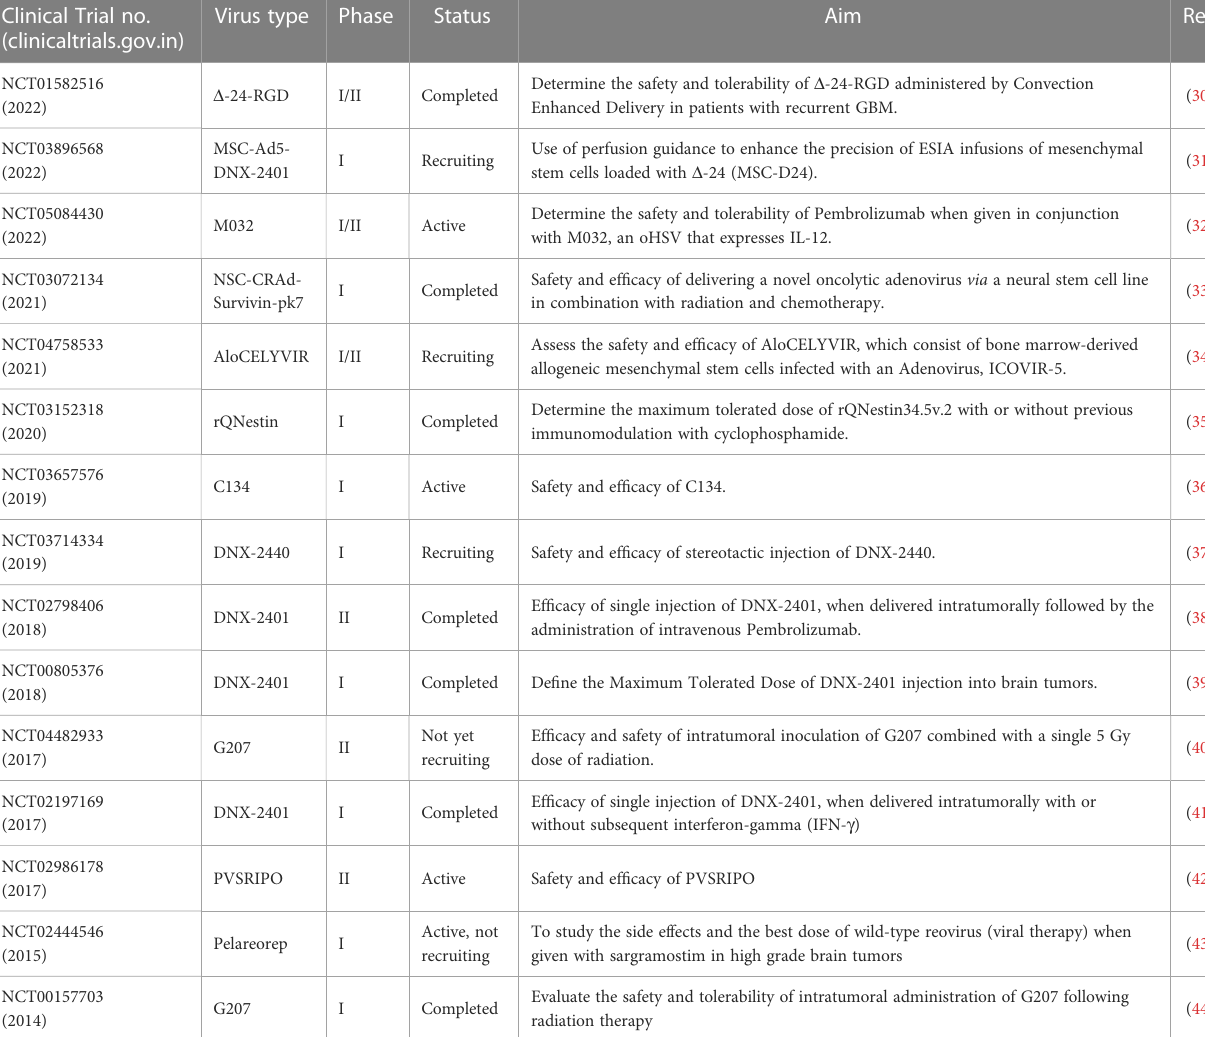
TABLE 1 Adenovirus, HSV & Poliovirus based oncolytic virus therapy for the treatment of brain tumors. Clinical Trial no. (clinicaltrials.gov.in)